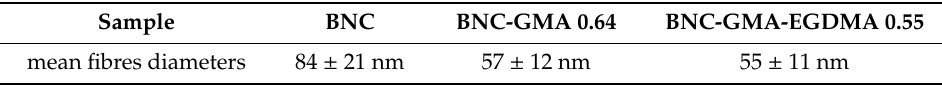
Table 4. Results from the dimensional analysis of BNC fibres displayed in the SEM micrographs.